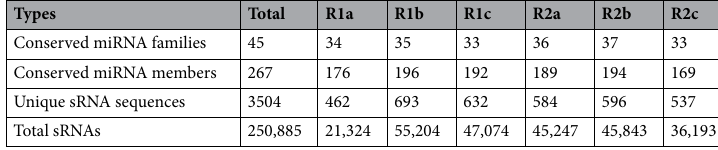
Table 2. Summary of conserved miRNAs identified between R1 and R2